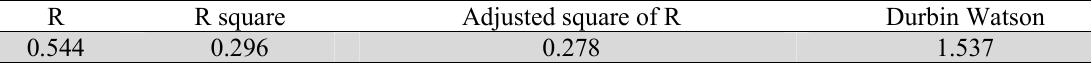
Regression model explanation